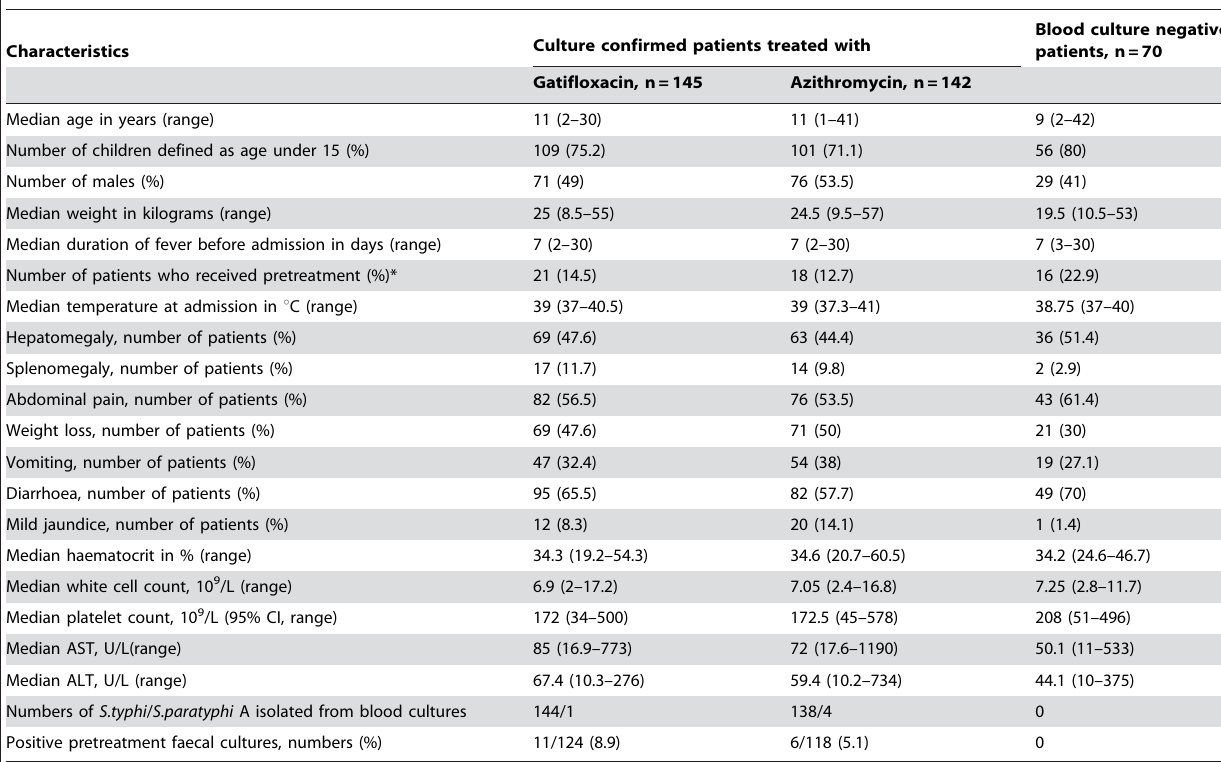
Table 1. Baseline characteristics of culture confirmed patients (PP analysis) and culture negative